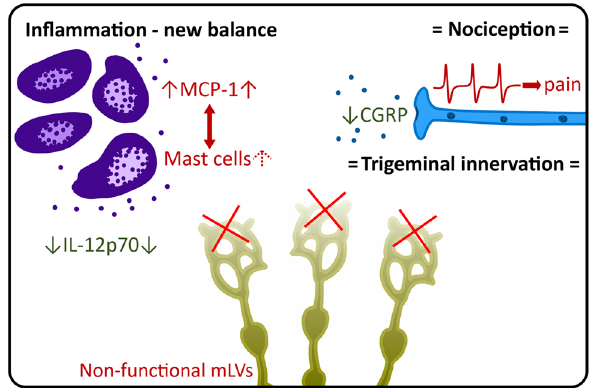
Figure 8. Summary of experimental findings. Dysfunctional meningeal lymphatic system triggers alterations in migraine mediator levels in the meninges. At basal conditions, the level of mast cell-activating cytokine MCP-1 is increased, supporting a possible increase in population of meningeal mast cells. In contrast, the release of CGRP and the level of pro-inflammatory IL-12p70 are decreased. However, these changes do not correspond to alterations in the trigeminal nociception. Finally, trigeminal innervation of the meninges was not changed, excluding a role of mLVs in this process. “Red” color indicates pro-inflammatory and pro-nociceptive changes; “Green” indicates anti-inflammatory and anti-nociceptive changes. Arrow up ( ↑ ) indicates an increase in the parameter, while arrow down ( ↓ ) indicates a decreased parameter. The equals sign (=) indicates unchanged